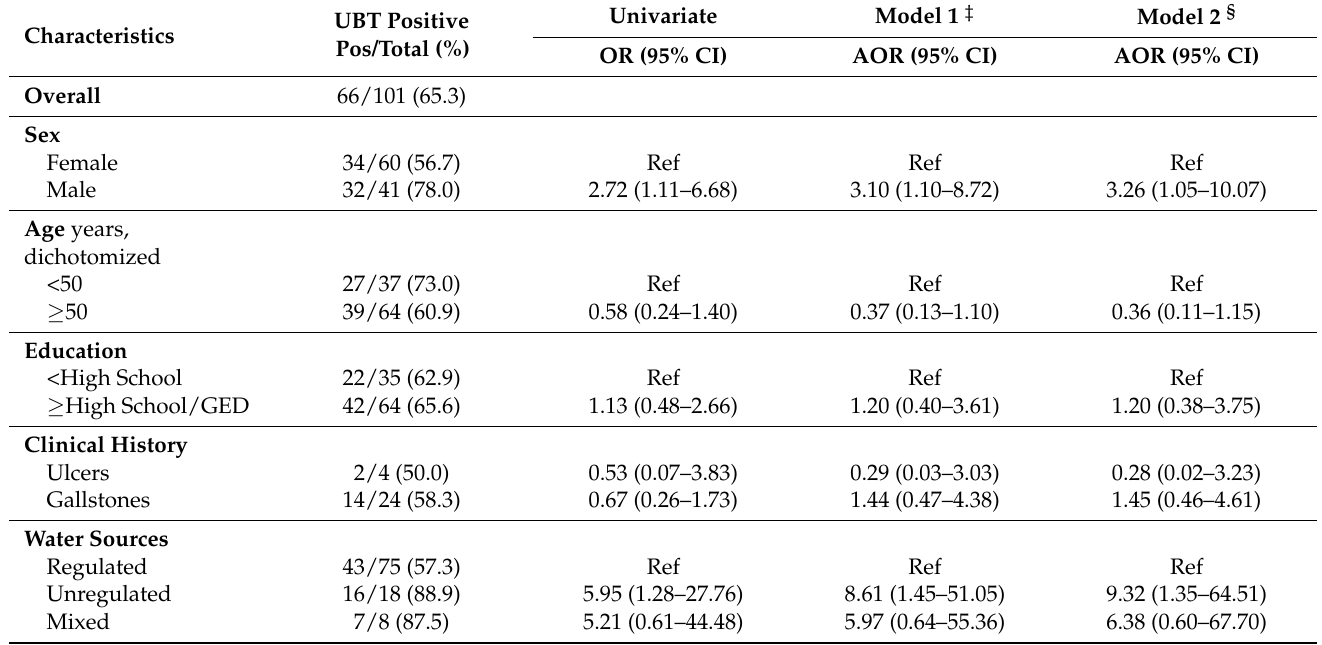
Table 2. Association between risk factors and prevalence of H. pylori infection as determined by urea breath test